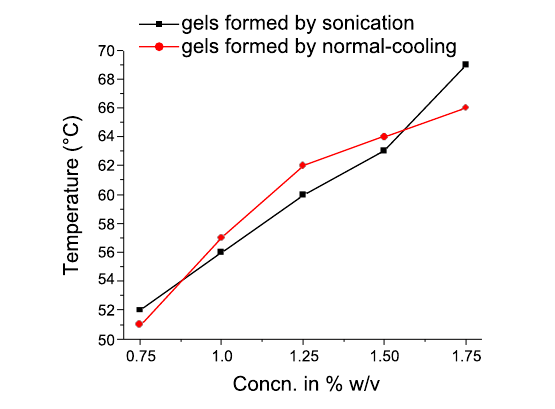
Figure 7: Gel melting profile of bis(2-hydroxyethyl)aminodeoxy- cholane 2 gel in 1:1 DMSO/water (normally cooled (red) and sonica- tion-induced (black)